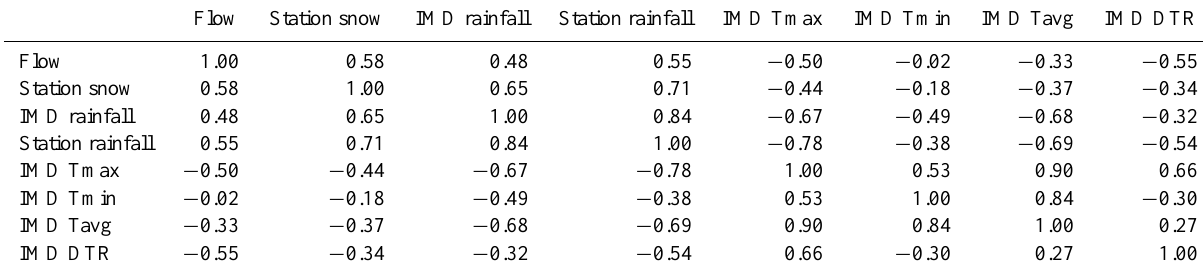
Table 2. Cross-correlations for different hydrometeorological variables for 1978–2004. Flow Station snow